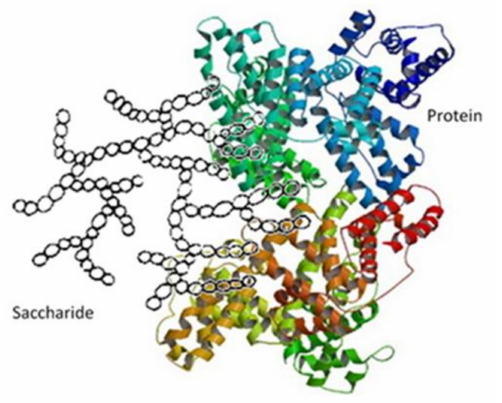
Figure 2. Proposed structure of